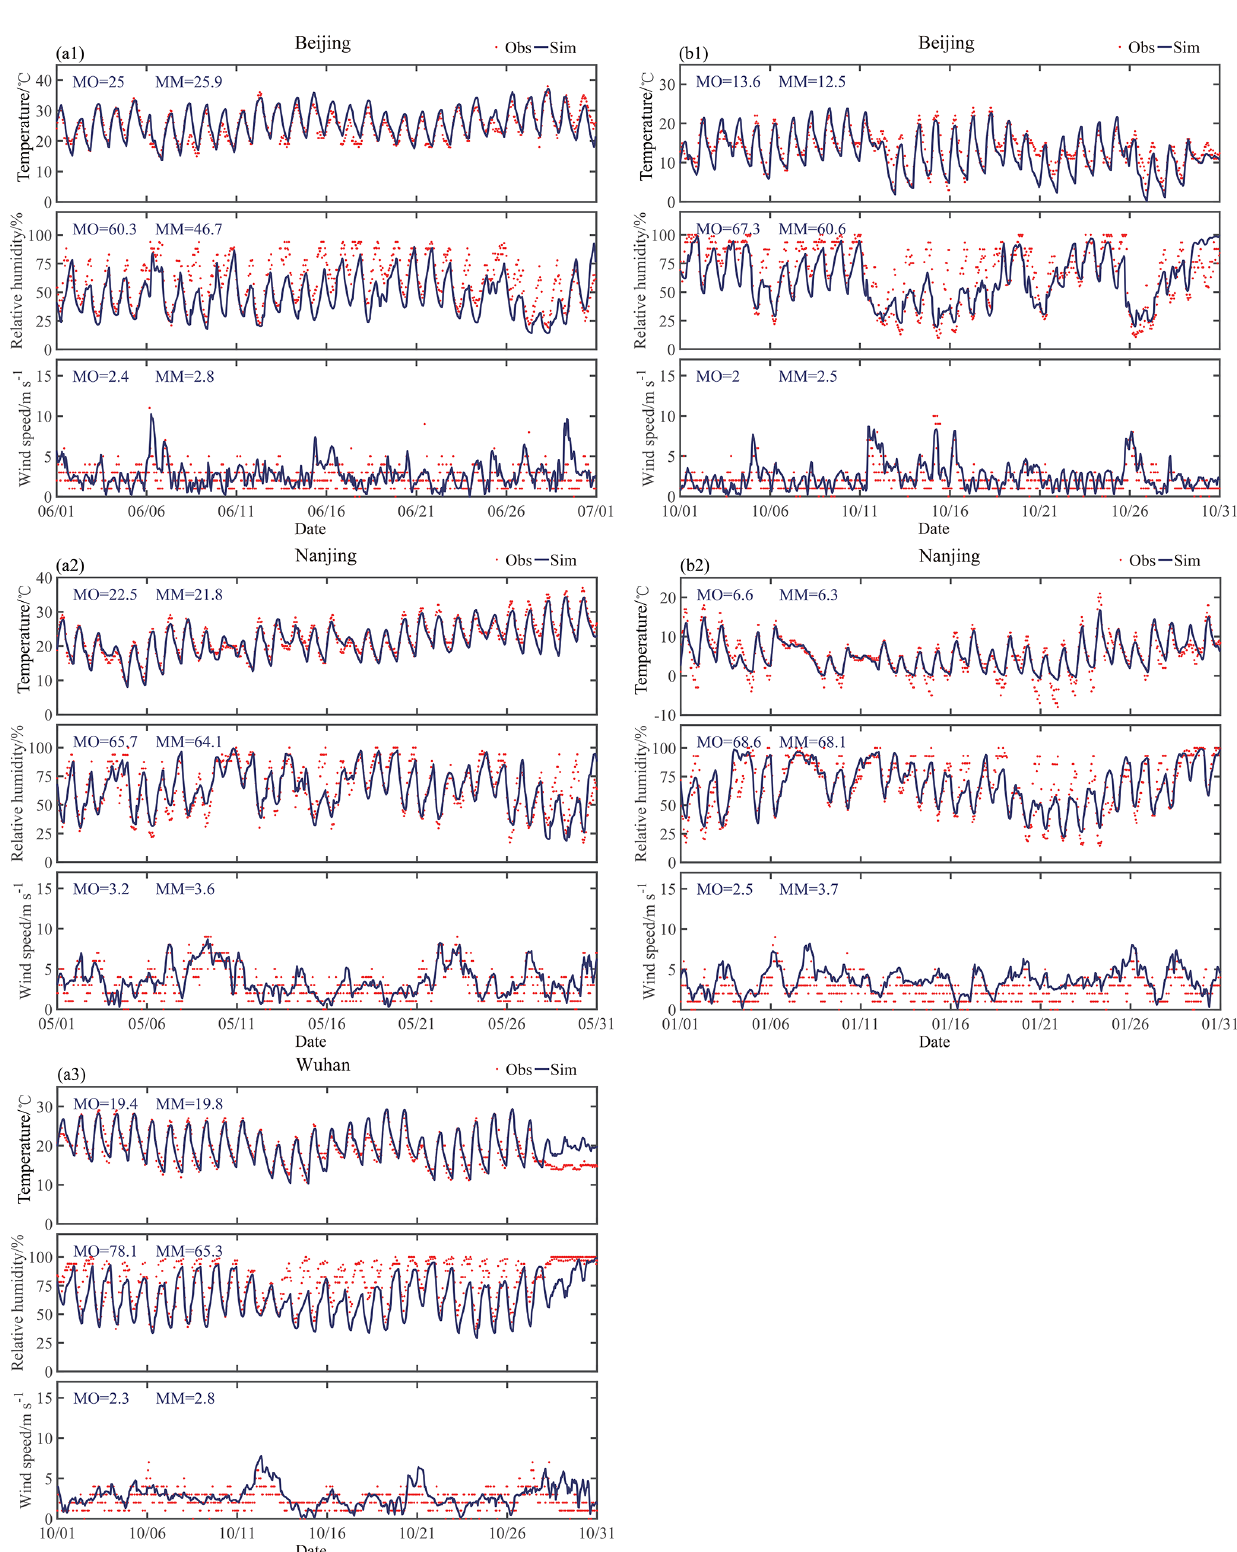
Figure 3. Comparison between observed and simulated meteorological factors (i.e., temperature, relative humidity and wind speed) in (a1) Beijing, (a2) Nanjing and (a3) Wuhan in the warm seasons and (b1) Beijing and (b2) Nanjing in the cold seasons of 2014. The red dots and blue lines represent hourly observations and simulations, respectively. Monthly mean values of the observation and simulation are also given on subplots in blue text, abbreviated to MO and MM,